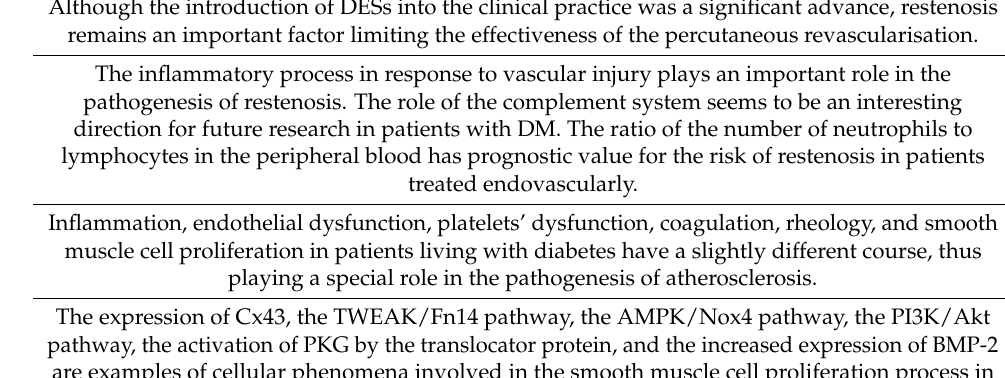
Table 6. Summary of the most important findings of our review of the literature. Although the introduction of DESs into the clinical practice was a significant advance, restenosis remains an important factor limiting the effectiveness of the percutaneous revascularisation. The inflammatory process in response to vascular injury plays an important role in the pathogenesis of restenosis. The role of the complement system seems to be an interesting direction for future research in patients with DM. The ratio of the number of neutrophils to lymphocytes in the peripheral blood has prognostic value for the risk of restenosis in patients treated